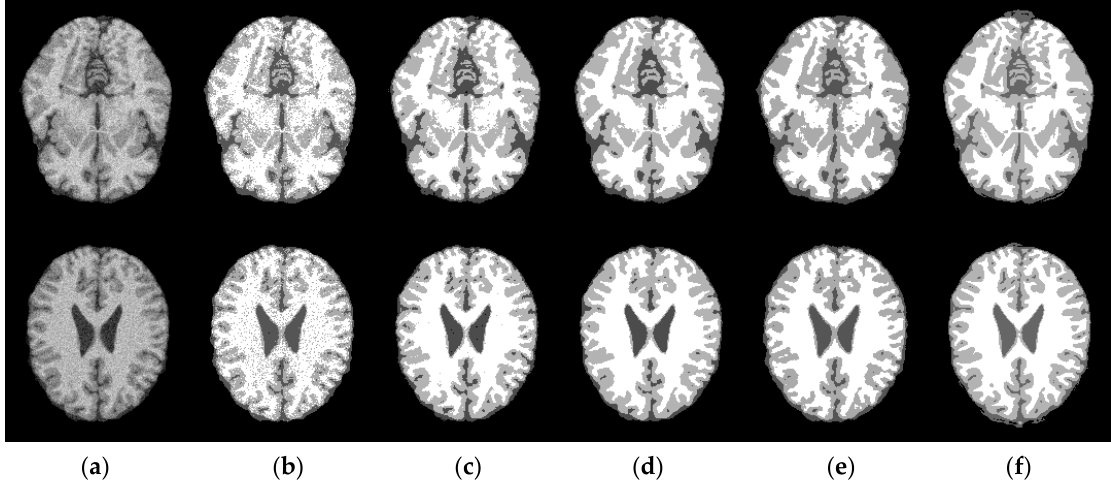
Figure 2. Comparison of the segmentation results of multiplicative intrinsic component optimization (MICO), bias-corrected fuzzy c-means (BCFCM), fuzzy local information c-means (FLICM), and RC_LCI: ( a ) original images; ( b ) segmentation results of MICO; ( c ) segmentation results of BCFCM; ( d ) segmentation results of FLICM; ( e ) segmentation results of RC_LCI; and ( f ) ground truth. Table 1. The iterations and CPU time of MICO, BCFCM, FLICM, and RC_LCI.